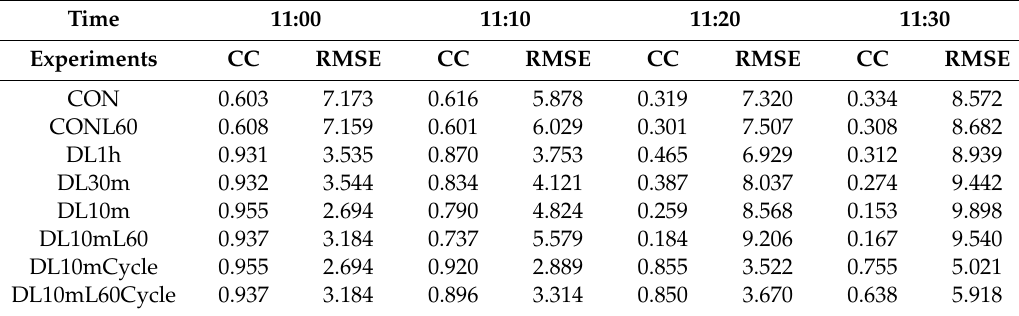
Table 2. Root mean square errors (RMSEs) and correlation coe ffi cients (CCs) between observed Vrs and estimated lidar data from eight